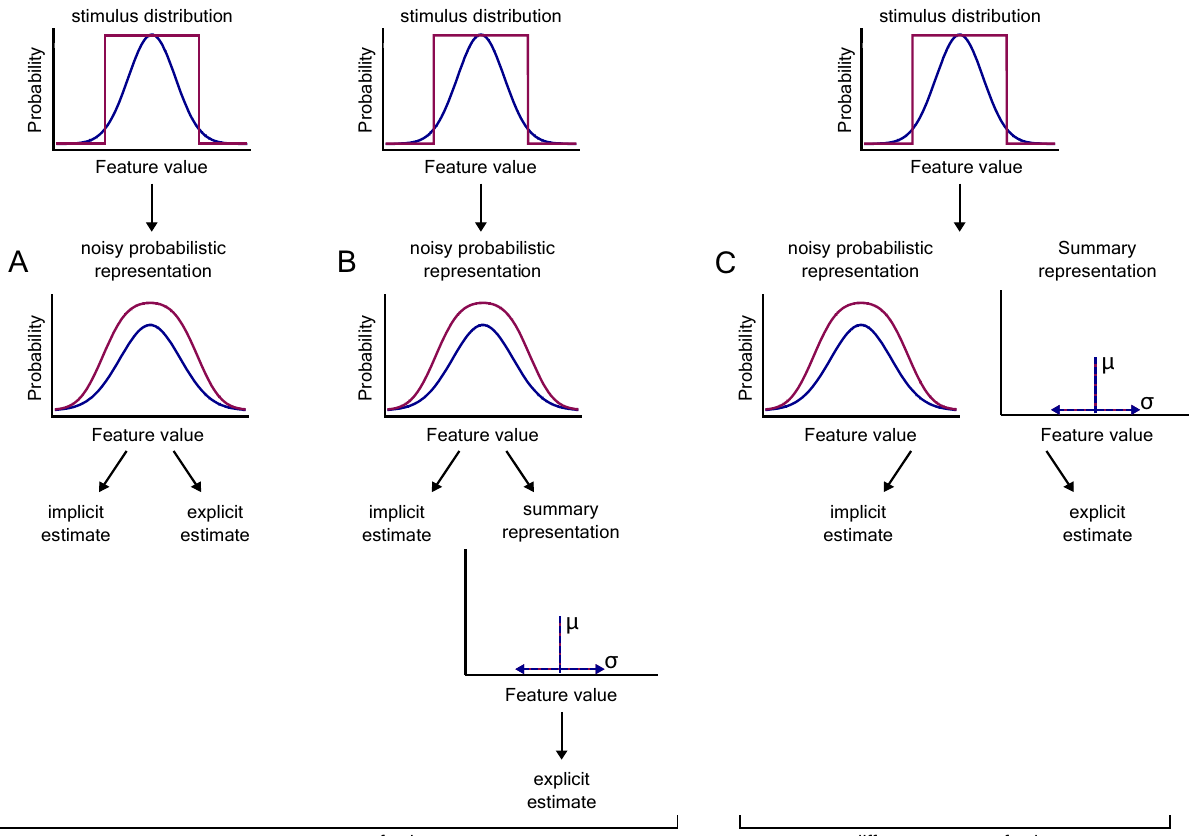
Figure 2. Schematic overview describing potential ways in which the visual system can represent stimulus distributions. A stimulus distribution is encoded as a noisy probabilistic representation (represented here as the stimulus distribution convolved with Gaussian noise) and ( A ) both implicit and explicit estimates are derived from this noisy representation or ( B ) a stimulus distribution is again encoded as a noisy probabilistic representation from which an implicit estimate is obtained and moreover, it allows the estimation of summary representations where the summary statistics of the stimulus representation are encoded, such as range and mean. This summary representation is then used to make explicit estimates about the stimulus ensembles. As a third option ( C ) the stimulus distribution is encoded with two different neural representations: while a noisy probabilistic representation is used for implicit estimates, a separate summary representation encodes the summary statistics of a stimulus distribution. The latter representation enables explicit